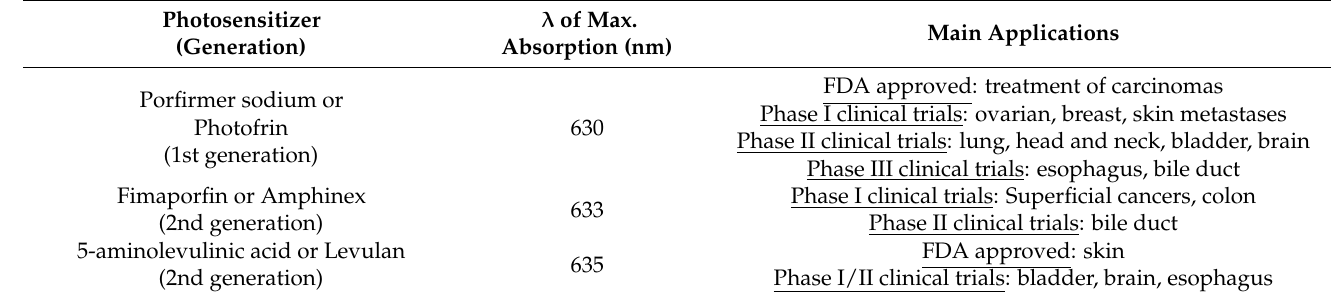
Table 1. Examples of PS used in the PDT [1,5,7,9,10,16,20–24].